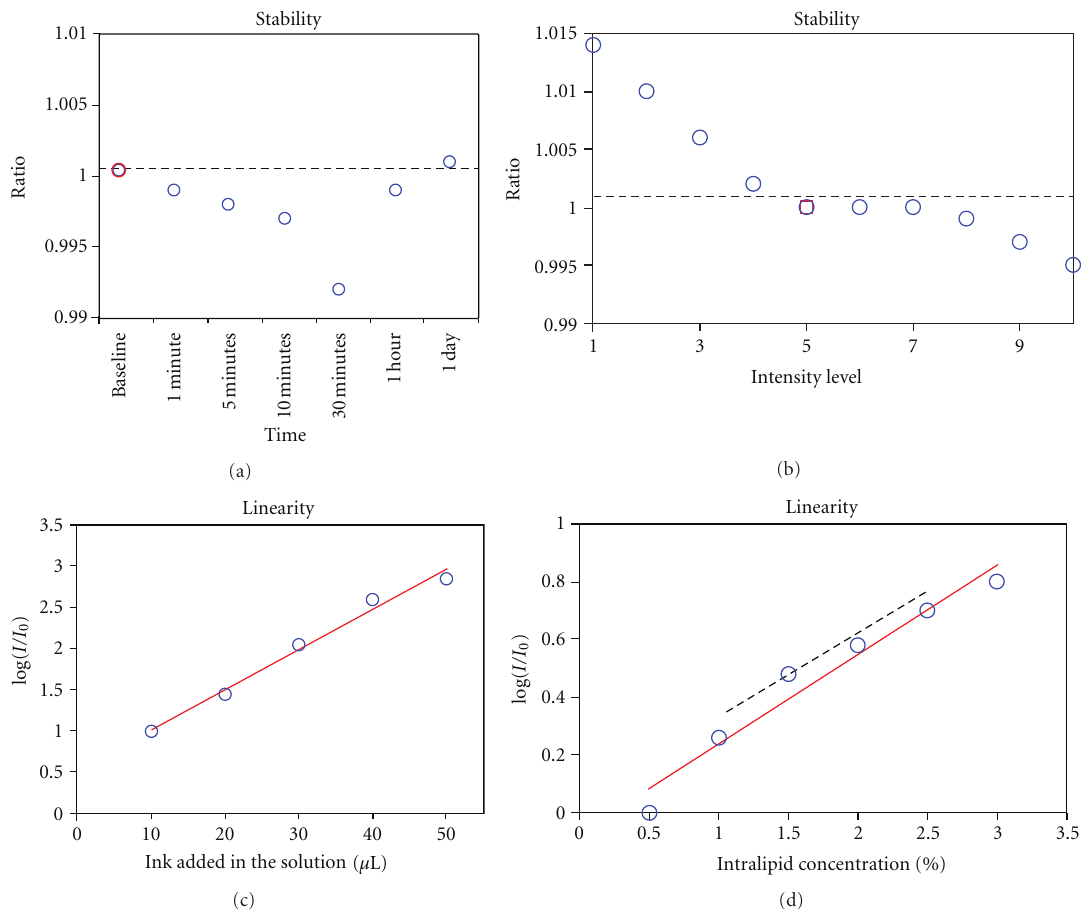
Figure 3: Ratio of the intensities ( I M /I B ) for a 1% Intralipid solution (a) at di ff erent times of measurement and (b) with di ff erent light intensities. The relationships between log( I 0 /I ) and (c) the volume of ink added into the testing solution for a 1% Intralipid solution, and (d) the concentration of Intralipid. Dashed line in (d) shows the linear relationship within Intralipid concentrations between 1% and 2.5%. 30 μ L, 40 μ L, and 50 μ L of diluted ink. The CCD